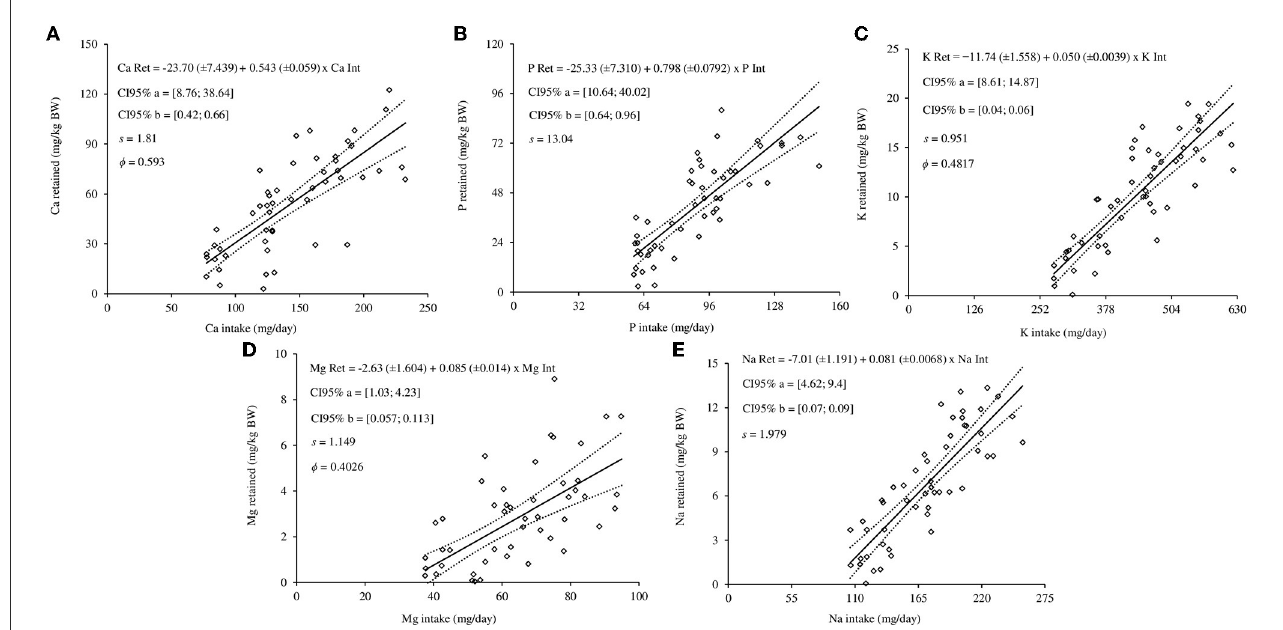
FIGURE2 Regression equations of the relationships between retentions (Ret) and intakes (Int) of calcium (A) , phosphorus (B) , potassium (C) , magnesium (D) , and sodium (E) of hair sheep. The diamonds are the observed values of macromineral retention for maintenance; the solid line represents estimated values; dashed lines represent lower and upper values of the 95% confidence interval (95% CI); a and b are the equation parameters; s is the standard deviation; φ is the scale parameter.